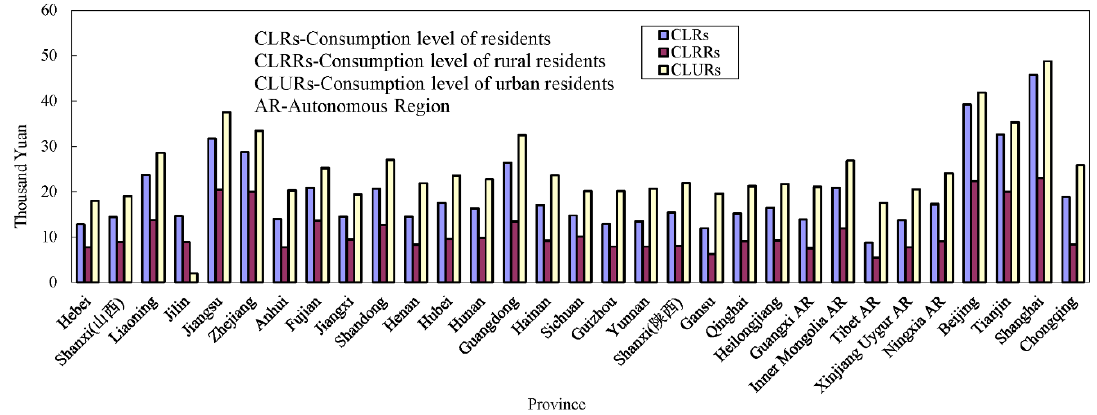
Figure 2. Consumption level of residents of mainland China in 2015 (7 yuan equals about $1 and data is from [38]).